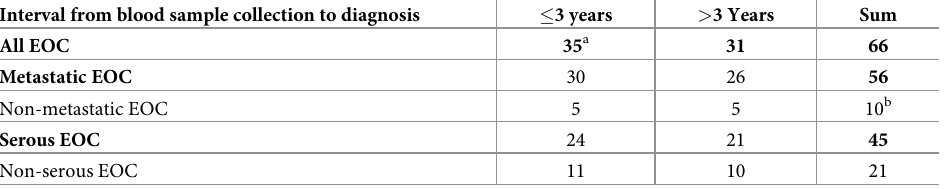
Table 2. Distribution of epithelial ovarian cancer (EOC) cases in analytical groups (bold text) of case-control dif- ferences in gene expression. Interval from blood sample collection to